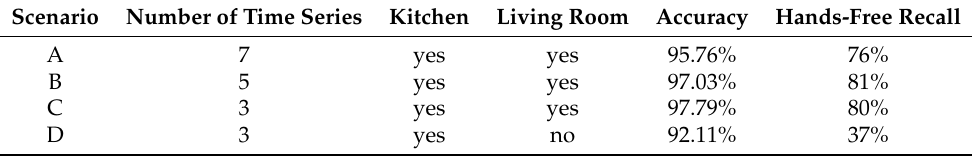
Figure 13. Scenario A confusion matrix for hands-free activity recognition. Table 2. Comparison of the 4 scenarios to analyze which time series are necessary for hands-free activity